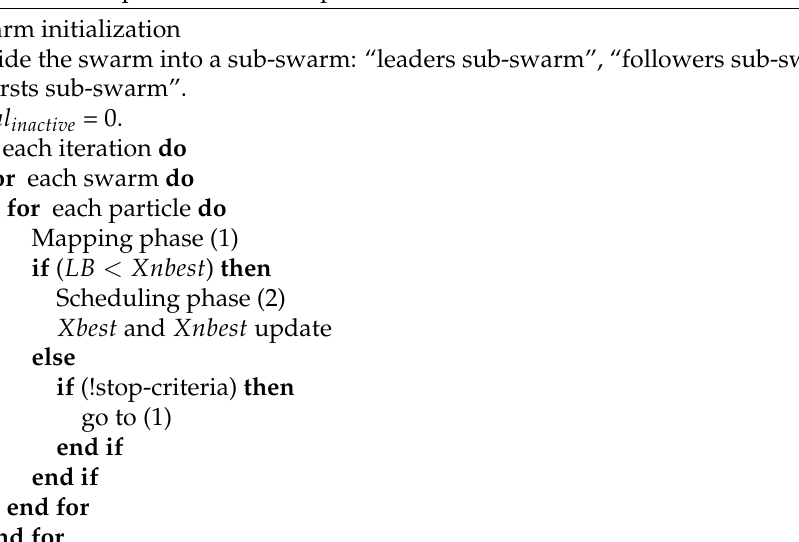
Algorithm 1 Adaptive E2L-PSO steps Swarm